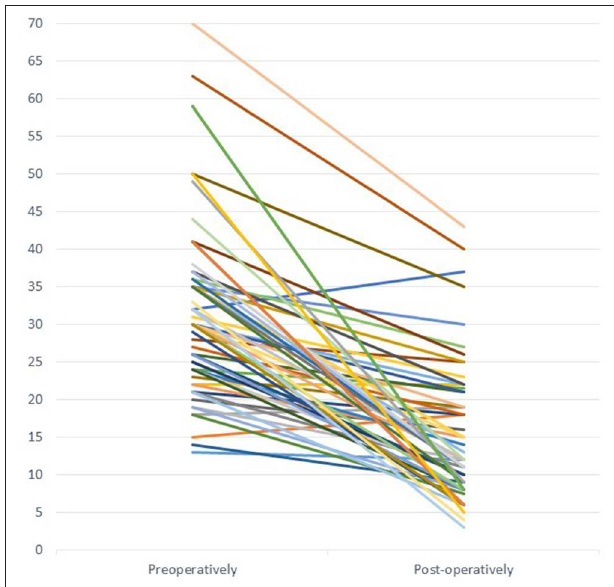
FIGURE 1 | Changes in pelvis diameter after pyeloplasty on ultrasound ( P < 0.0001).